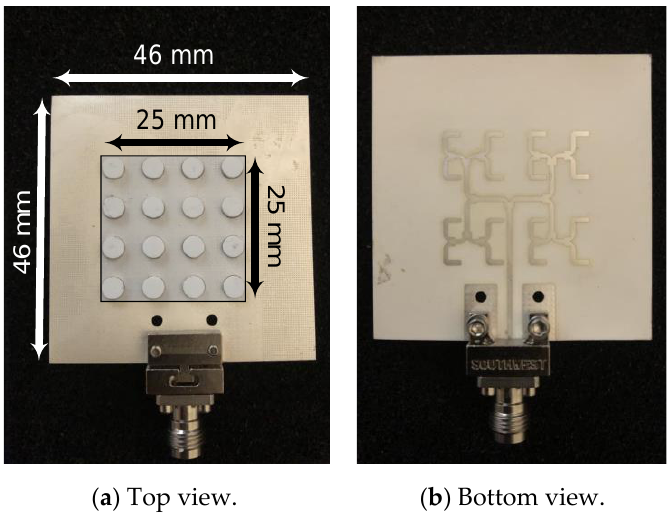
Figure 13. Fabricated DRA array antenna.